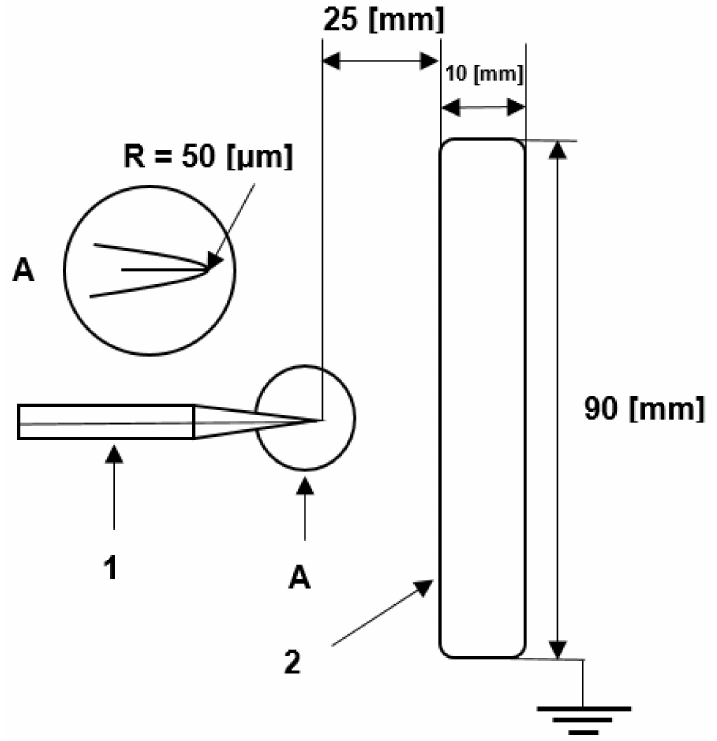
Figure 4. Electrode system applied in the studies: 1, point electrode; 2, grounded